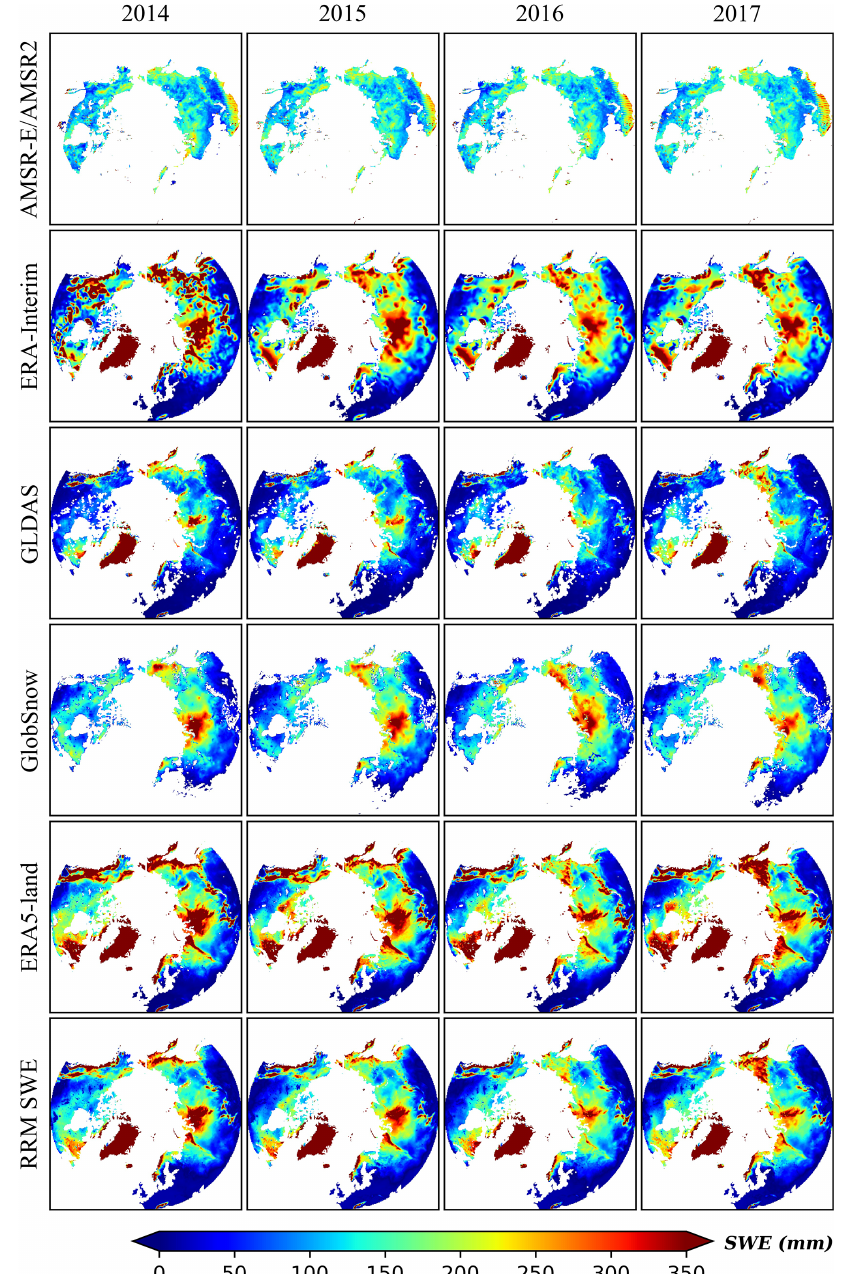
Figure 6. Comparison of the spatial distribution characteristics between the RRM SWE and AMSR-E/AMSR2 SWE, ERA-Interim SWE, GLDAS SWE, GlobSnow SWE, and ERA5-Land SWE (the four columns of images represent the comparison results in 2014, 2015, 2016, and